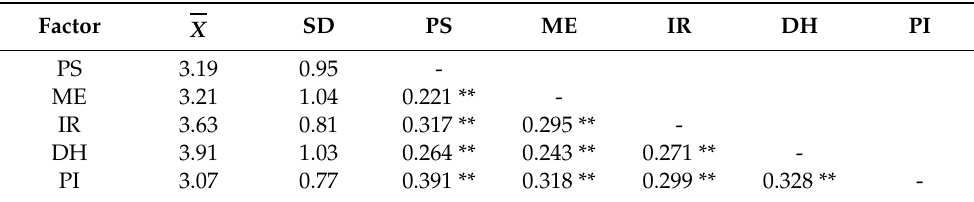
Table 4. Descriptive statistics and